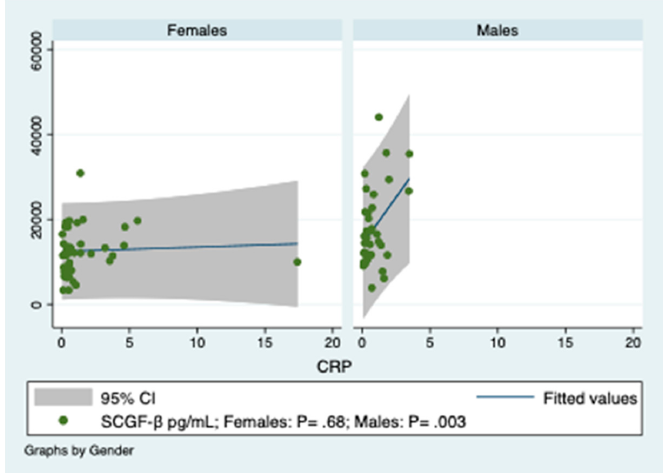
Figure 2. Prediction of SCGF- β serum concentrations by C-reactive protein (CRP) levels. CRP, C reactive protein. Y -axis reports SCGF- β serum concentrations. The regression line, obtained by linear regression, in the graph of males is sloped at an angle confirming that there is a strong relationship. CRP is expressed in mg/mL.